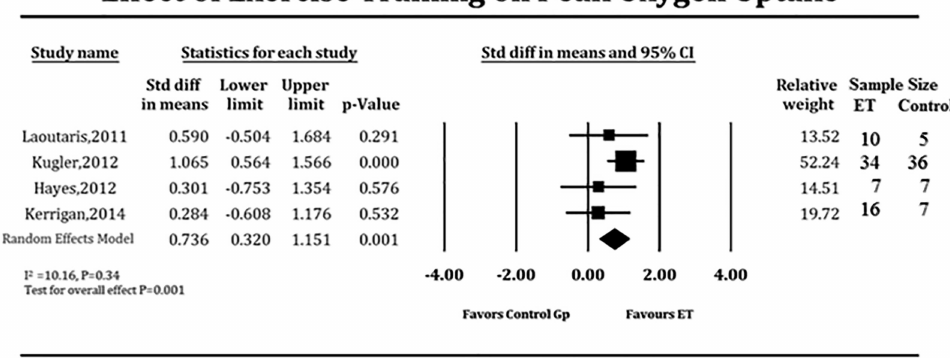
Fig 2. Forest plot depicting effect of supervised exercisetraining on exercisecapacity measuredas peak oxygen uptake (ml/kg / min). ET = exercise training, Gp = group.